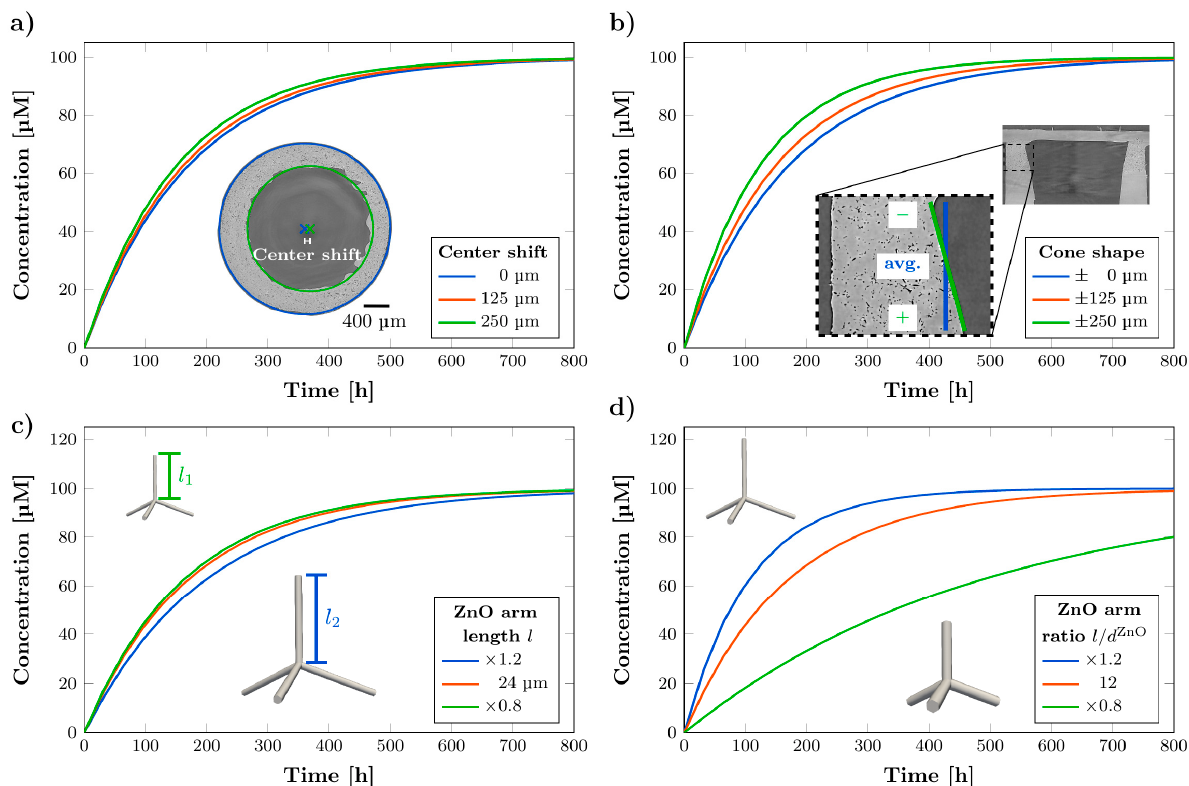
Figure 6. Simulated concentration curves showing the influence on the release kinetics by ( a ) a center shift of the reservoir, ( b ) cone shape of the reservoir, ( c ) size of the tetrapods in terms of the arm length with constant ratio l/d and ( d ) ratio of the arm length to arm diameter of the tetrapods.